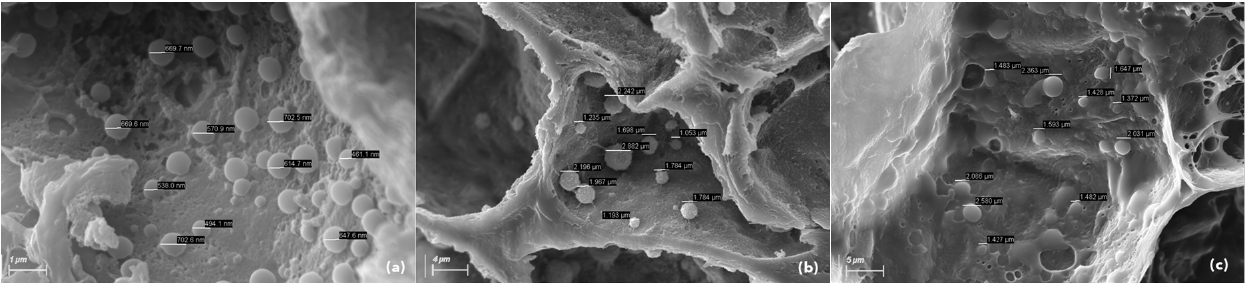
Figure 8. Scanning Electron Micrograph showing unknown bacterial endophytic cells in sandalwood seed ( a , b ) and hypocotyl tissue of seedling ( c ). The location of the bacterial cells is indicated by the scale bars.